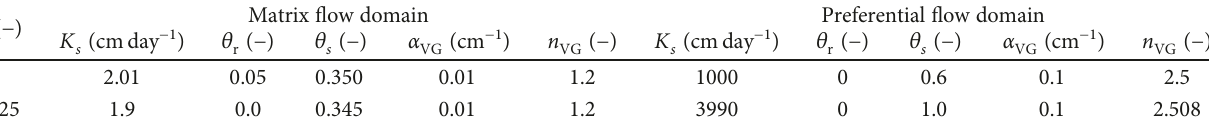
Table 4: Equi fi nal parameter sets of the bimodal soil hydraulic function for a hypothetical single-continuum soil. w ( −